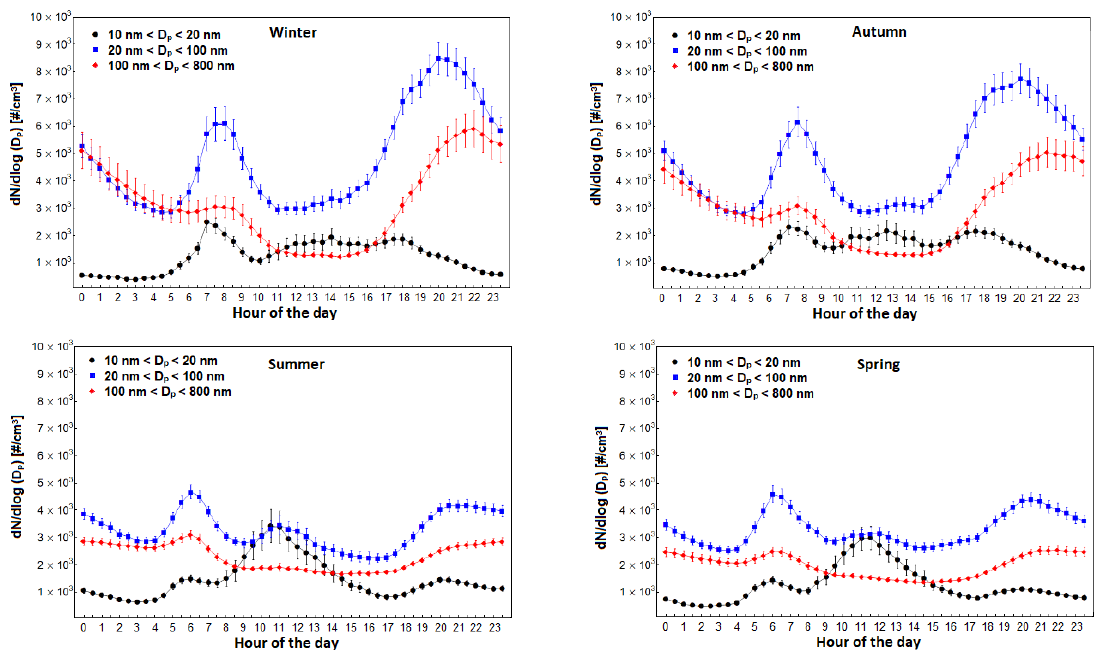
Figure 6. Temporal evolution of particle number concentration of N NUC (black dots), N AIT (blue dots), and N ACC (red dots) over the four seasons, averaged over five years. Vertical bars represent standard errors.